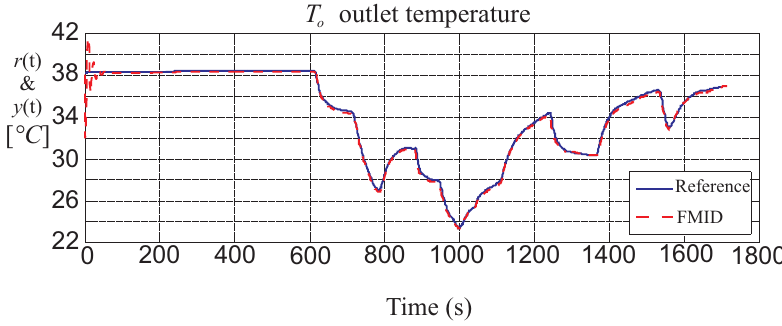
Figure 9. TU outflow air temperature with the Takagi–Sugeno (TS) fuzzy regulator derived via the FMID toolbox.